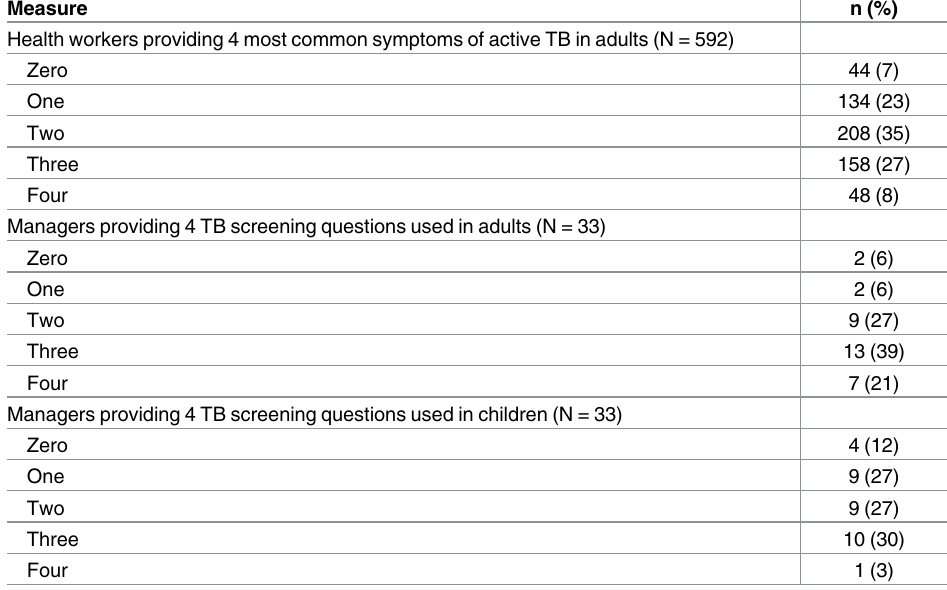
Table 3. Answers from health workers and managersto questions regarding TB screening in adults and